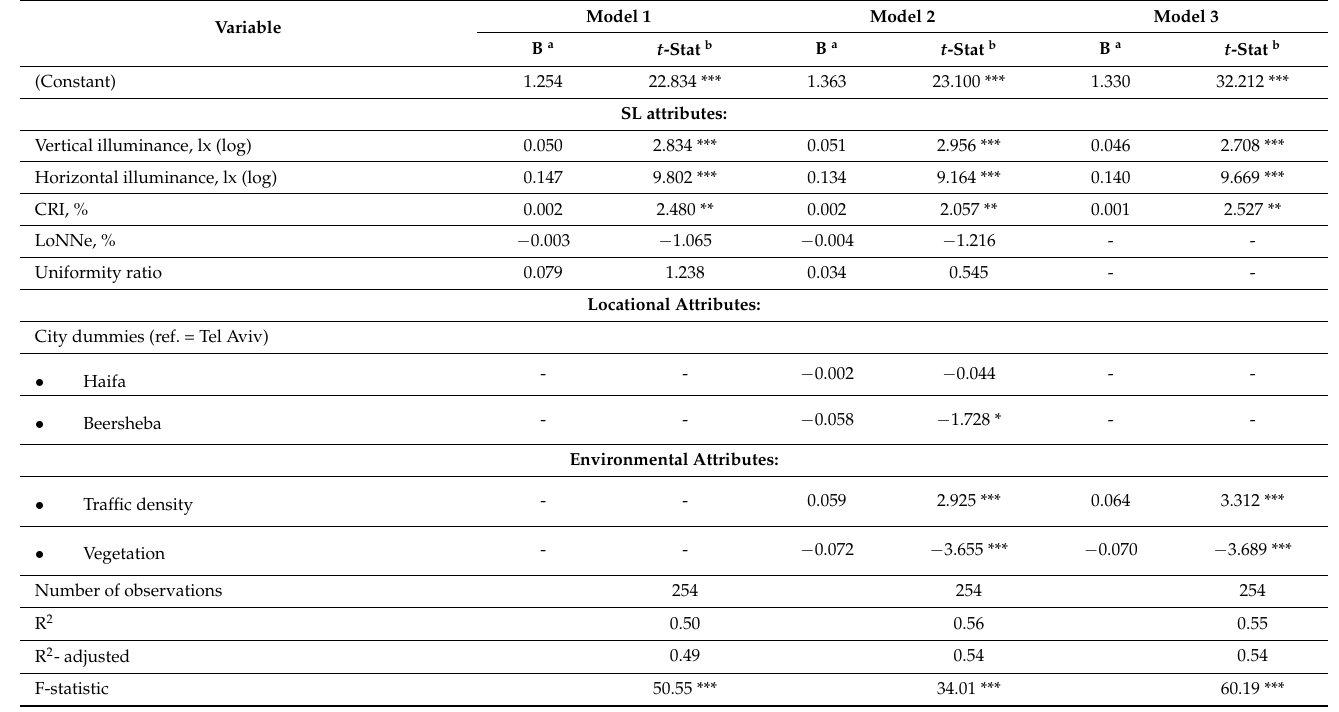
Table 2. Factors affecting PLQI in the study cities (Method—ordinary least square (OLS) regression). Variable